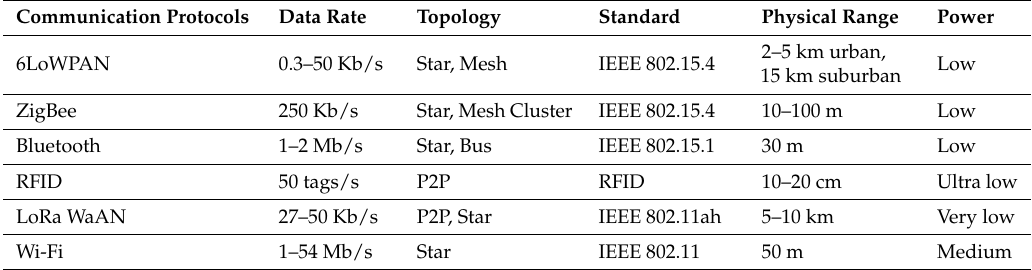
Table 3. Wireless communication protocols used in Precision Agriculture